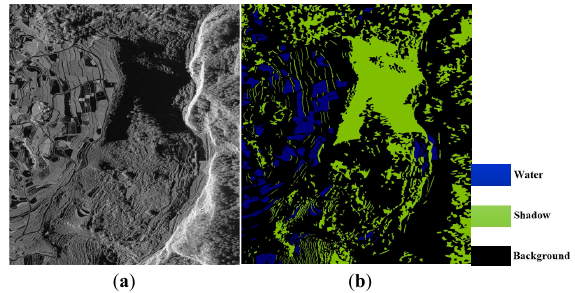
Figure 11. The first experiment data. ( a ) SAR image. ( b ) Ground truth.